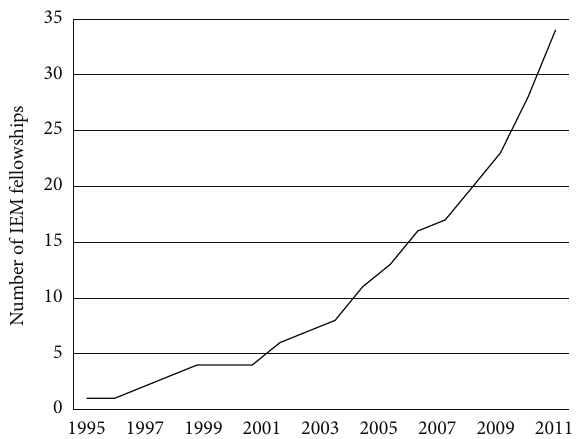
Figure 1: Cumulative number of IEM fellowships over